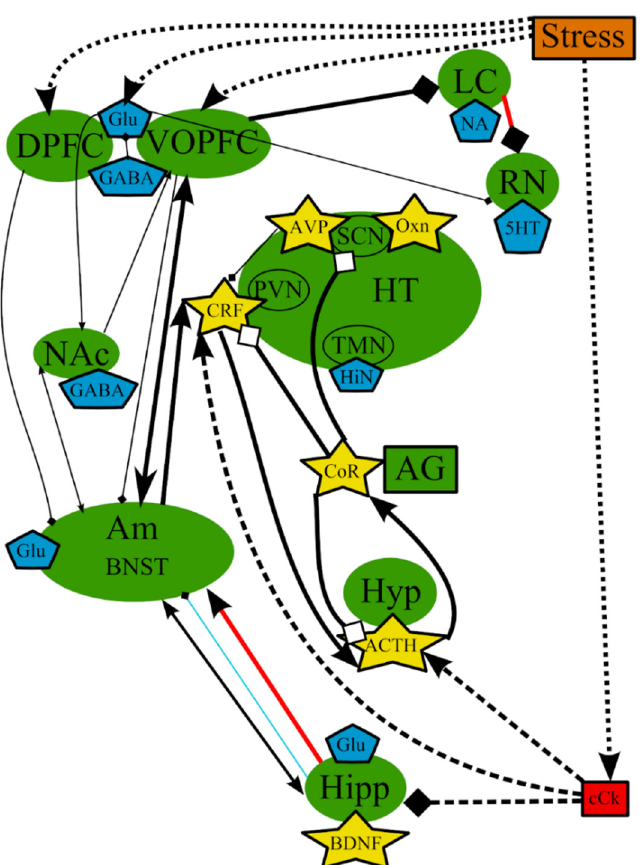
Figure 2. The hypothesis of stress-induced depression: main structures, neurotransmitters,